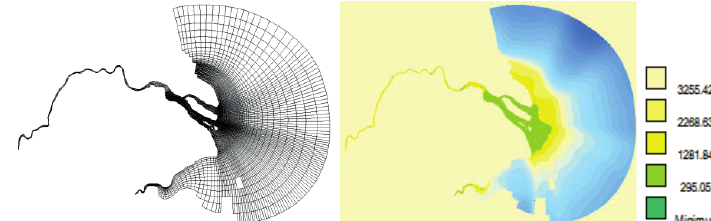
Fig. 2 Grid size of the estuary